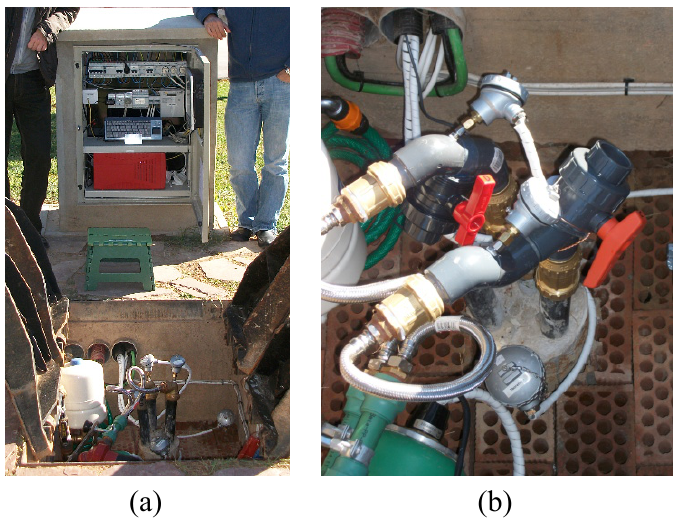
Figure 7. Image of the field test installation ( a ) and detail of the insertion/extraction valves ( b